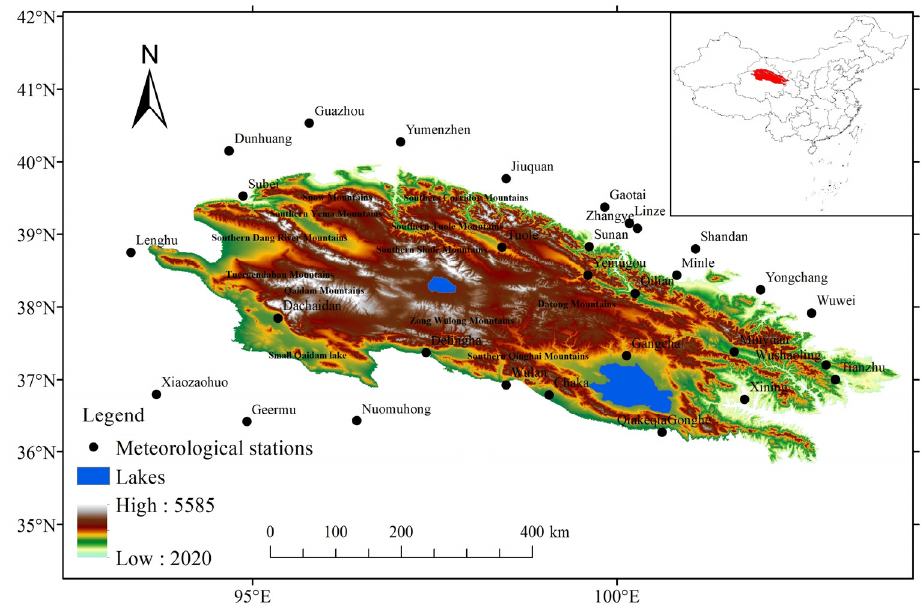
Figure 1. Location and topography of the study region (elevation given in meters above sea level).